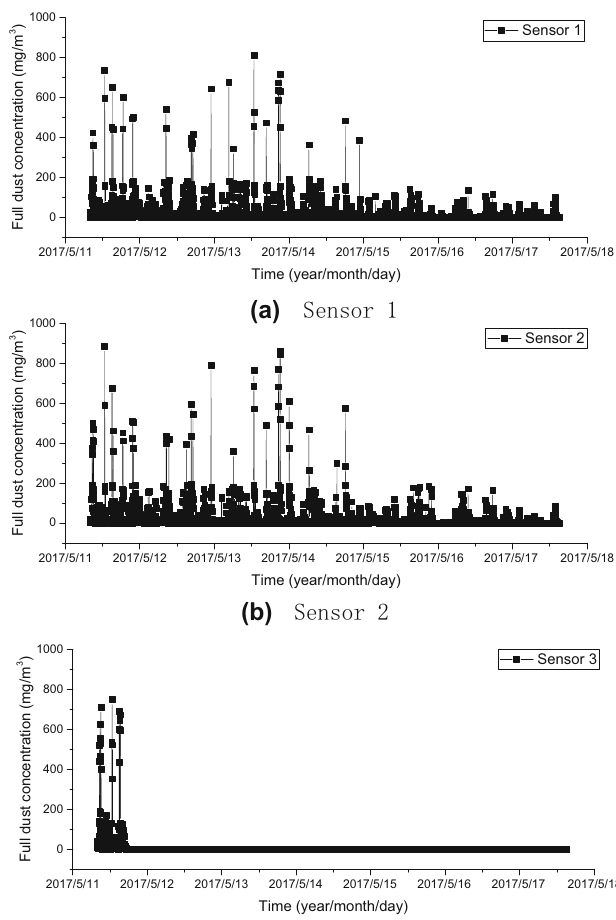
(c) (cid:54)(cid:72)(cid:81)(cid:86)(cid:82)(cid:85)(cid:3)(cid:22)